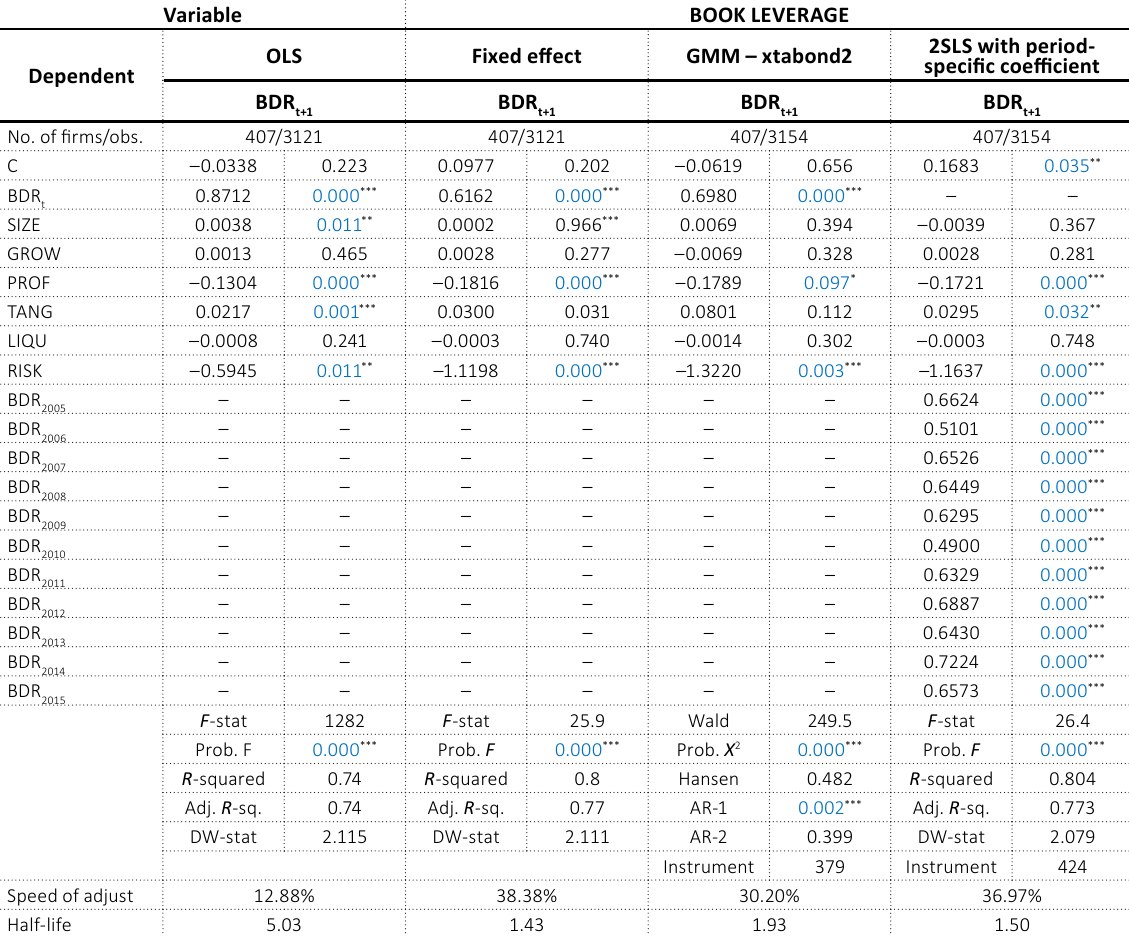
Table 3. Full sample analysis using firm-specific